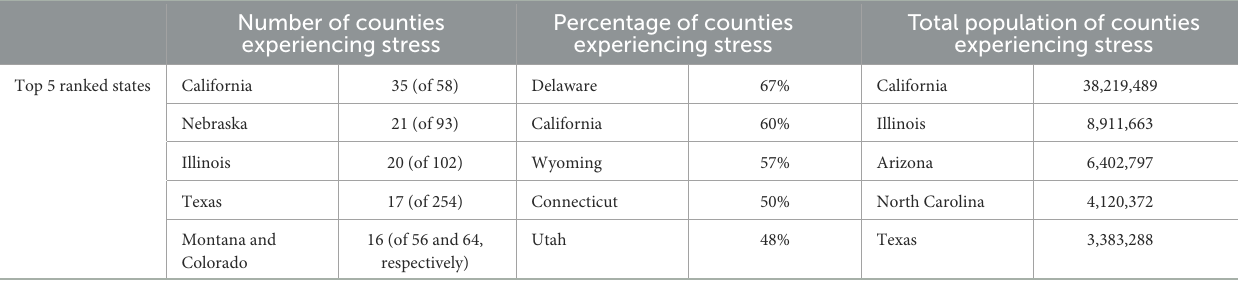
TABLE 2 Summary of results from the combinatory risk metric combining water stress and water quality.